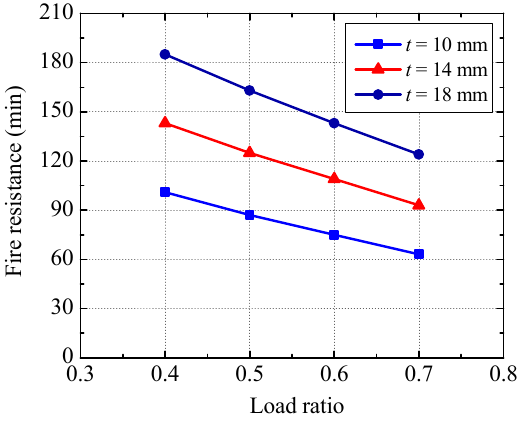
Figure 29. Variation of fire resistance with a load ratio (without longitudinal reinforcements).